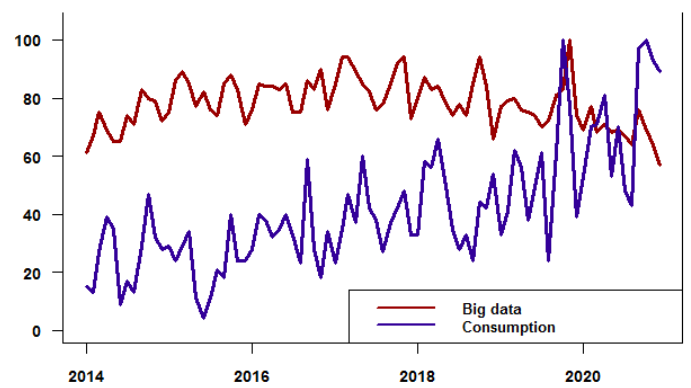
Figure 13. Big Data and SDG 12 global Google trends since